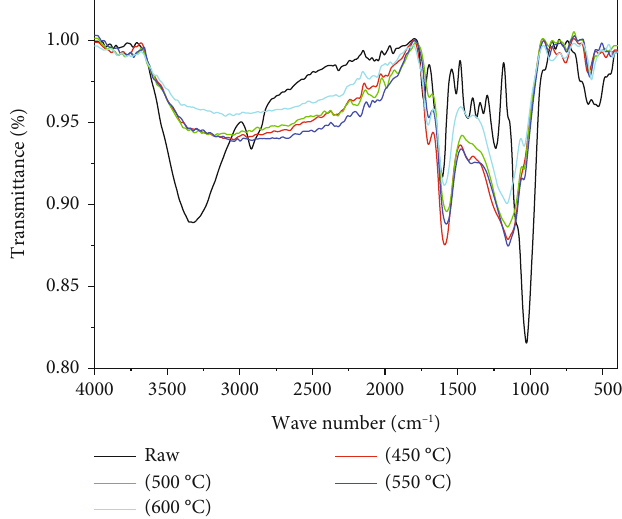
Figure 3: The FT-IR spectra for raw and TAADFPs activated at di ff erent